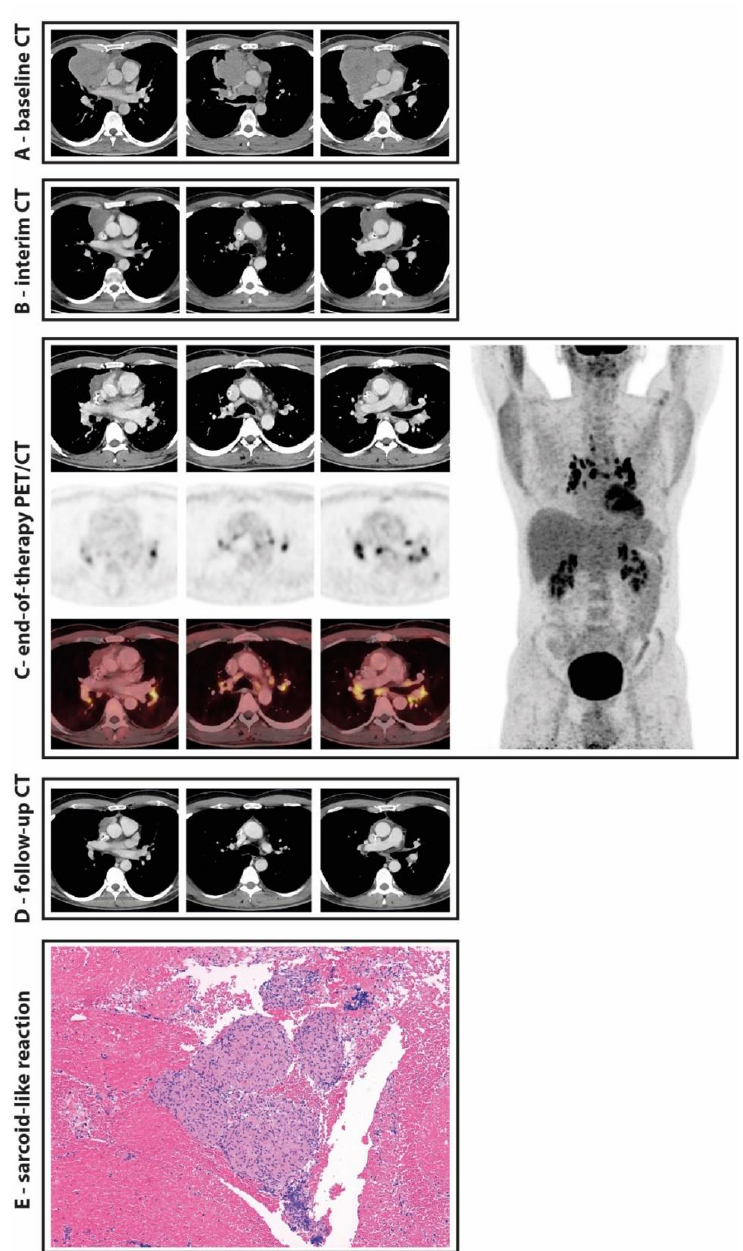
Figure 1. A 55-year-old male patient with primarily mediastinal diffuse large B-cell lymphoma (DLBCL; A ) underwent 6 cycles of chemotherapy and 2 cycles of rituximab (R-CHOP-14). At interim staging after 3 cycles of therapy, CT-based partial response was achieved ( B ). After completion of therapy ( C ), staging was carried out using 18F-FDG PET/CT imaging for an additional assessment of metabolic response. The pre-existing mediastinal lymphoma manifestation continued to decrease significantly in size ( C ) in addition to a complete metabolic response (Deauville 2). At the same time, however, multiple newly enlarged and hypermetabolic mediastinal and bilateral hilar lymph nodes (SUVmax 17) were detected in locations previously unaffected by the DLBCL ( C ). These findings triggered a biopsy with endobronchial ultrasound and transbronchial needle aspiration. The following histological workup determined multiple epithelioid cell granulomas without any necrosis or lymphomatous tissue, which was compatible with a sarcoid-like reaction ( E ). The subsequent CT staging 3 months later without any further therapy showed a normalization in size of the mediastinal and bilateral hilar lymph nodes ( D ).